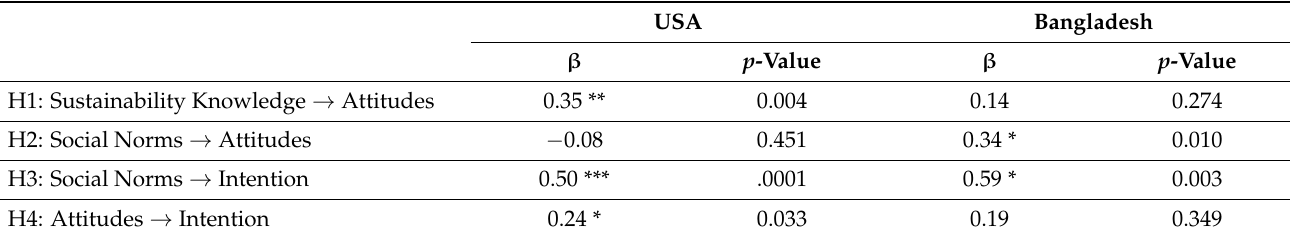
Figure 1. Comparison of standardized estimates from SEM analysis. Significance * p < 0.05, ** p < 0.01, *** p < 0.001. Here a represents the USA dataset and b represents the Bangladeshi dataset. Table 2. Path analysis result (USA vs